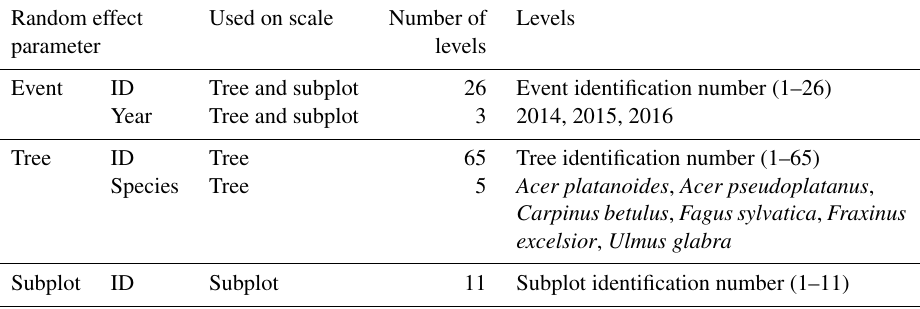
Table 2. Type, number and range of values of categorical variables used as random effects in the linear mixed effects models on the named